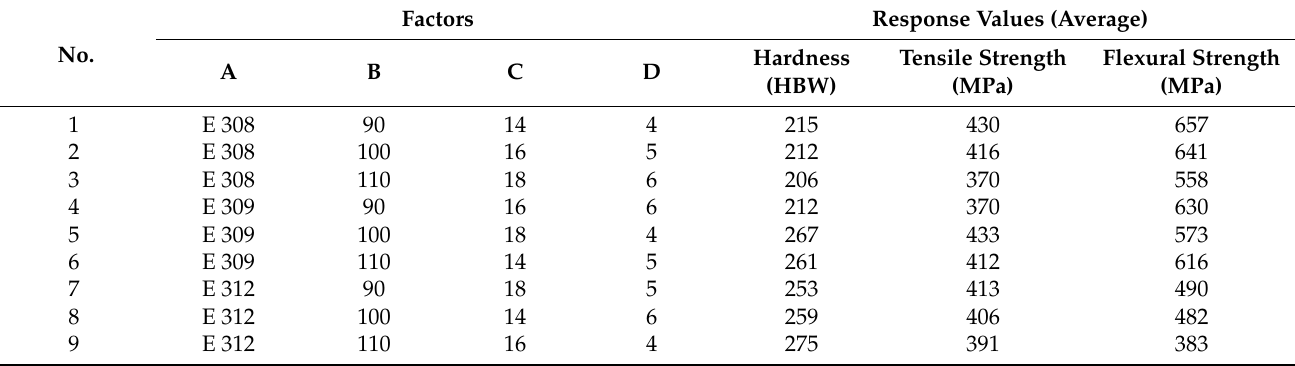
Table 4. Orthogonal array (L9) experimental results.